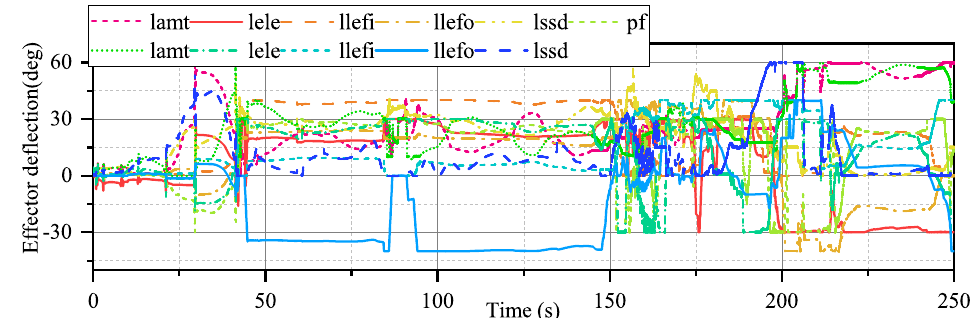
Figure 13. Effector deflections in presence of